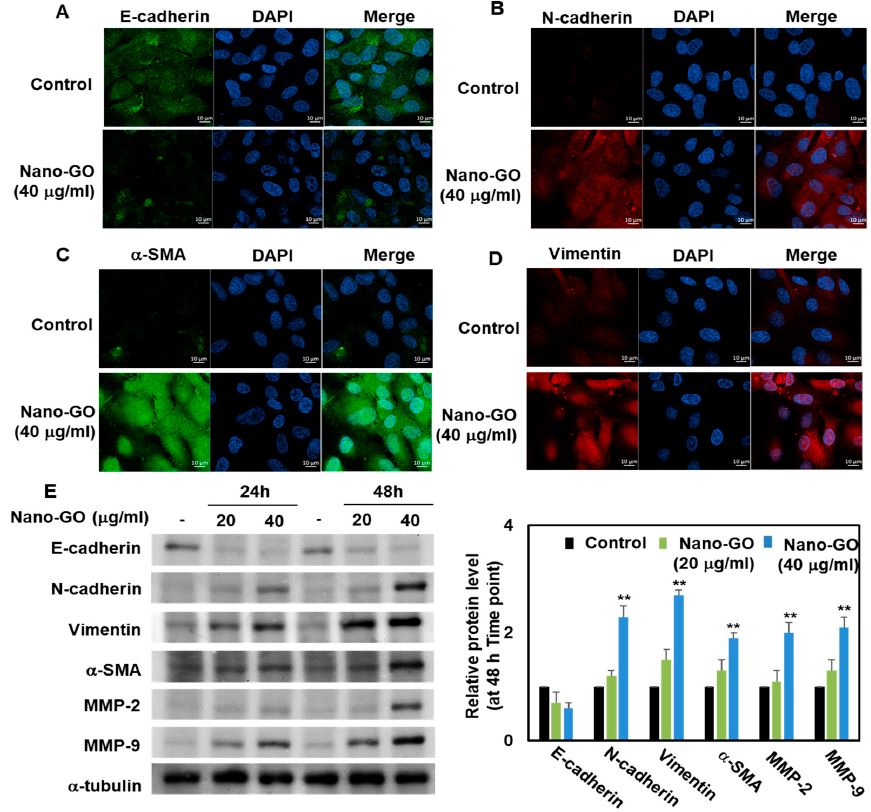
Figure 5. Effect of Nano-GO on protein expression of E-cadherin, N-cadherin, vimentin, α -SMA, MMP-2, and MMP-9. RPE cells were immunostained for E-cadherin ( A ), N-cadherin ( B ), α -SMA ( C ), and vimentin ( D ) in the absence or presence of Nano-GO (20 and 40 μ g/mL, for 24 h). Immunofluorescence images were taken using a 63× oil objective (scale bar; 10 μ m). ( E ) Representative western blotting-based image (right panel) and quantitative analysis (left panel) show the protein expression of E-cadherin, N-cadherin, vimentin, α -SMA, MMP-2, and MMP-9 in RPE cells. DAPI was used to determine the nuclei. All data are presented as the mean ± SEM ( n = 3). * p < 0.05 and ** p < 0.01 compared to the Control.